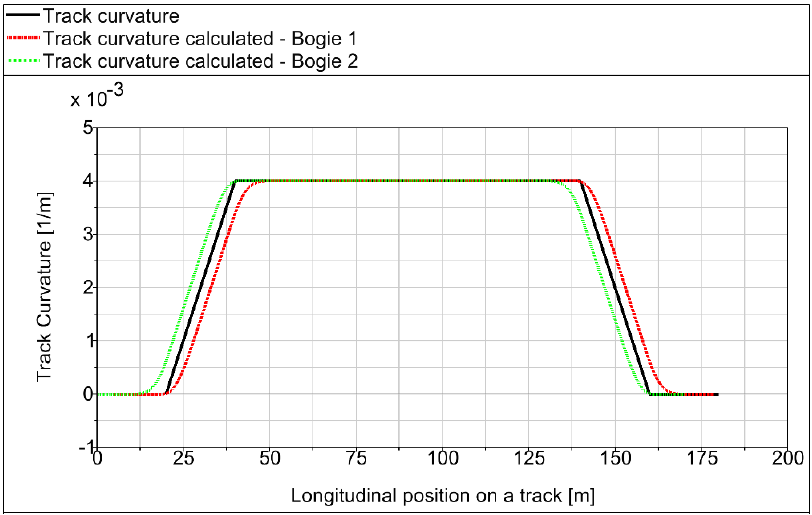
Figure 7. Track curvature estimated by bogie to car body rotation.